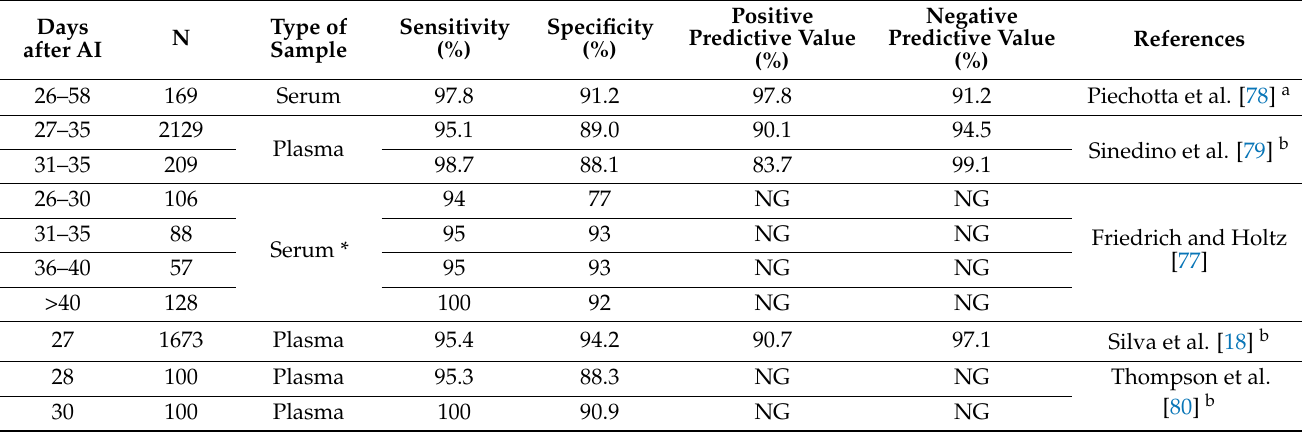
Table 4. Accuracy of in-house early-pregnancy associated glycoproteins (PAGs) ELISA tests for diagnosing early pregnancy in dairy